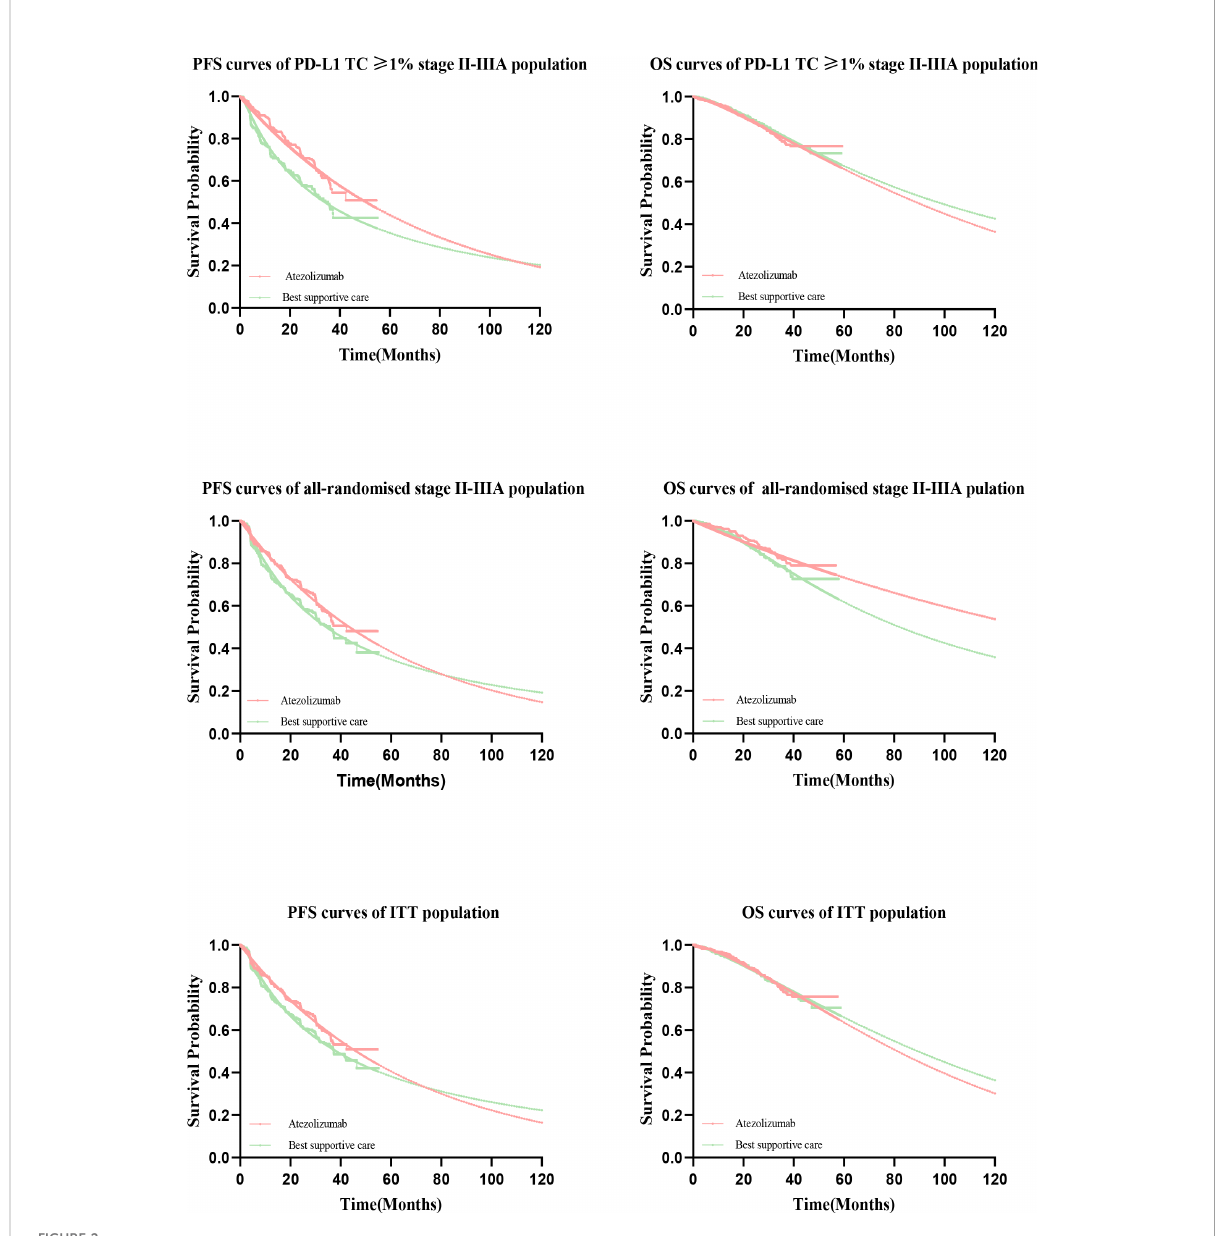
FIGURE 2 Comparison of Kaplan-Meier curves with fi tted curves in the IMpower010 trial. PFS, progression-free survival; OS, overall